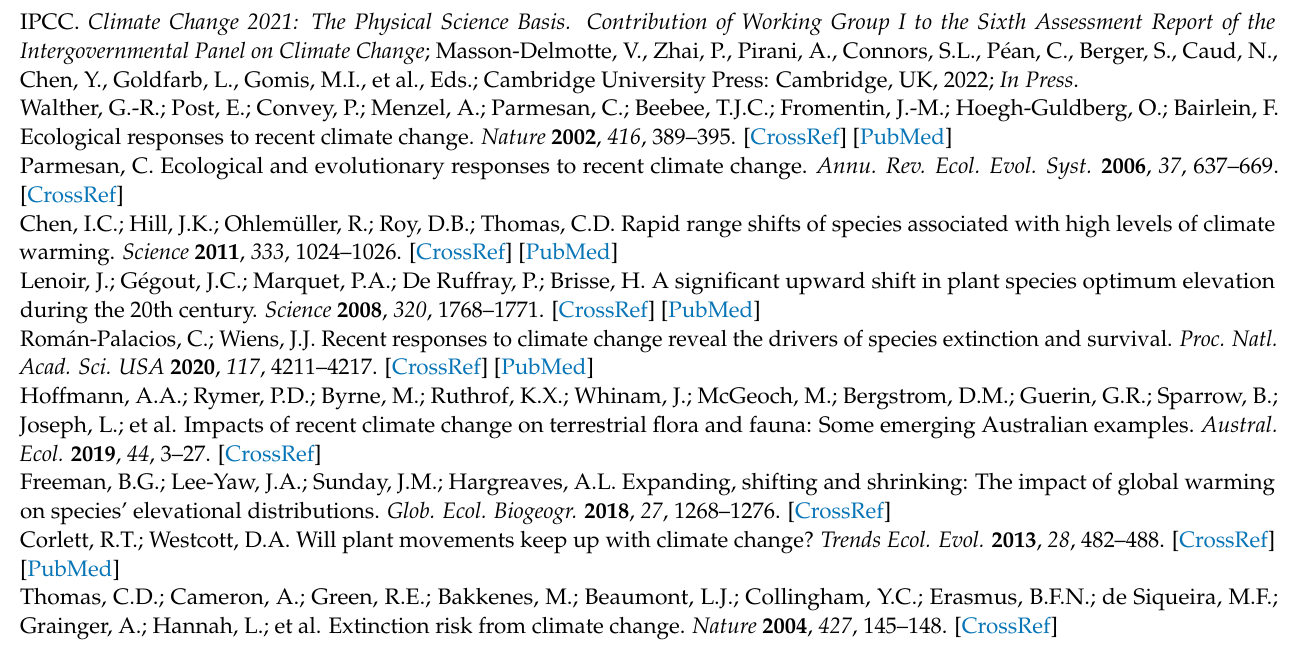
Figure S14: Median centroids for current and future (2070) projected distributions of Ophrys insectifera , for the GeoThin ensemble for all GCMs and two SSPs (SSP2-4.5 and SSP3-7.0); Figure S15: Median centroids for current and future (2090) projected distributions of Ophrys insectifera , for the GeoThin ensemble for all GCMs and two SSPs (SSP2-4.5 and